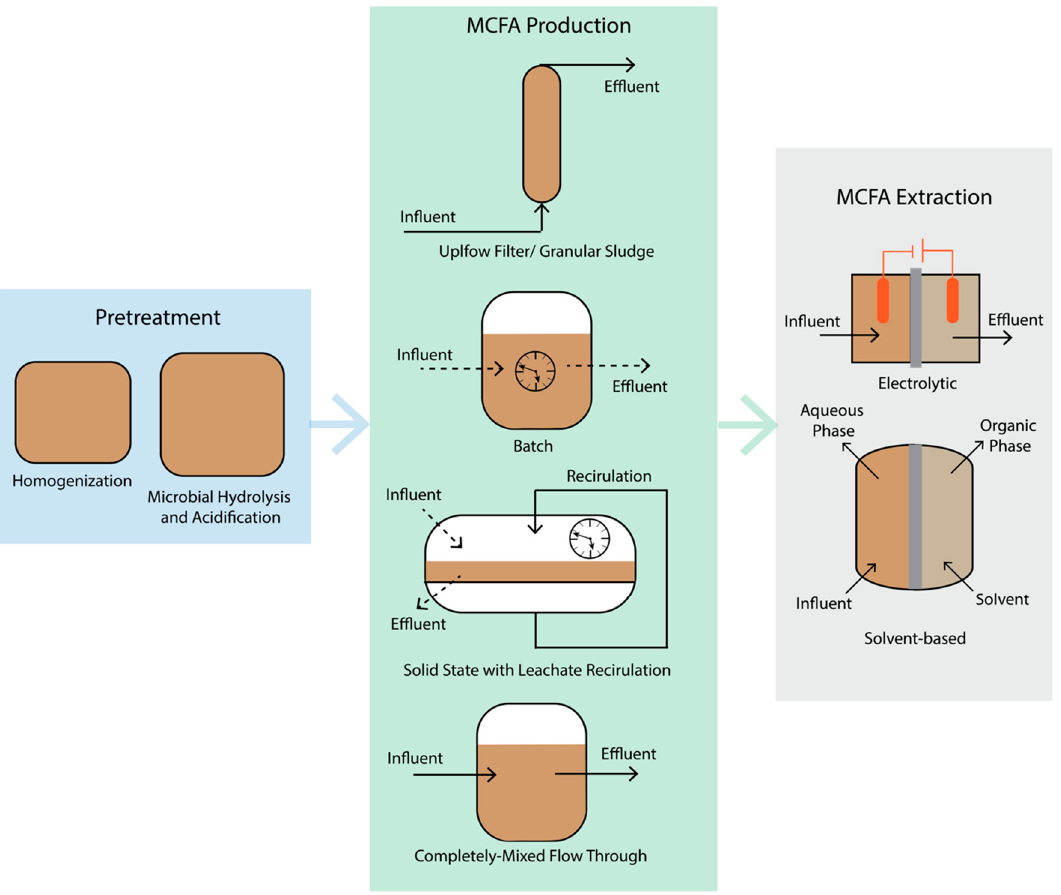
Figure 1. Processes for converting organic wastes to MCFAs. Several processes have been implemented for converting organic waste streams to MCFAs.